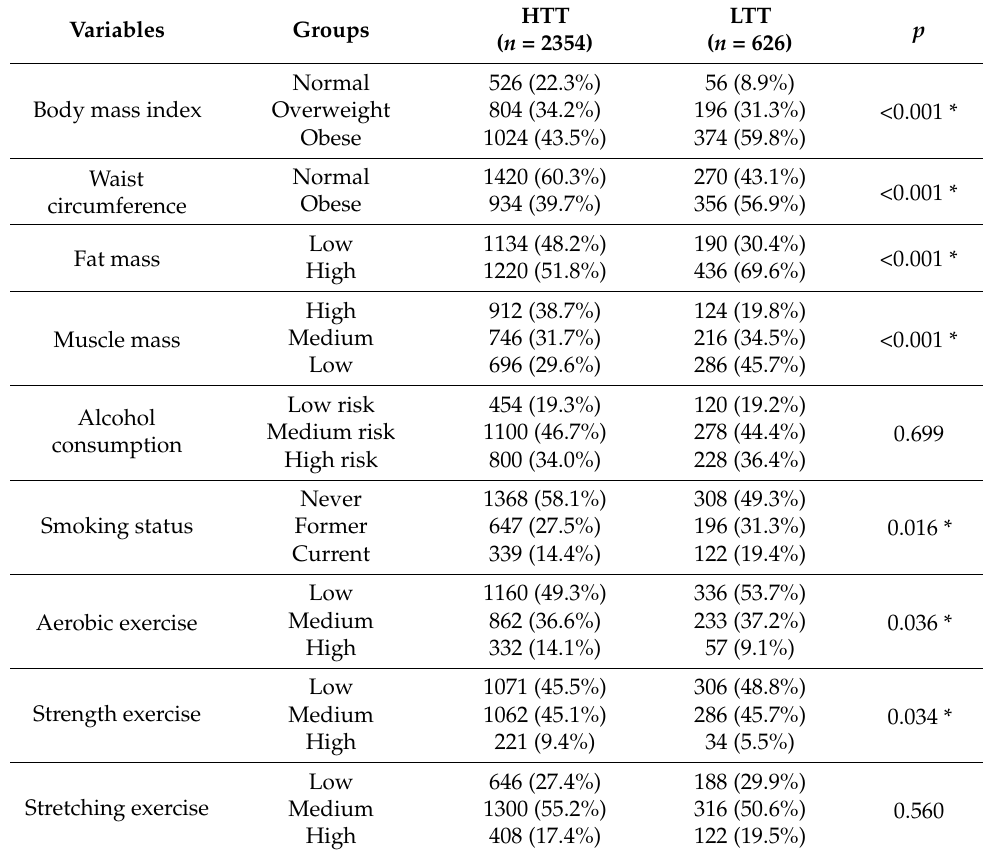
Table 2. High testosterone and low testosterone ratio of categorized